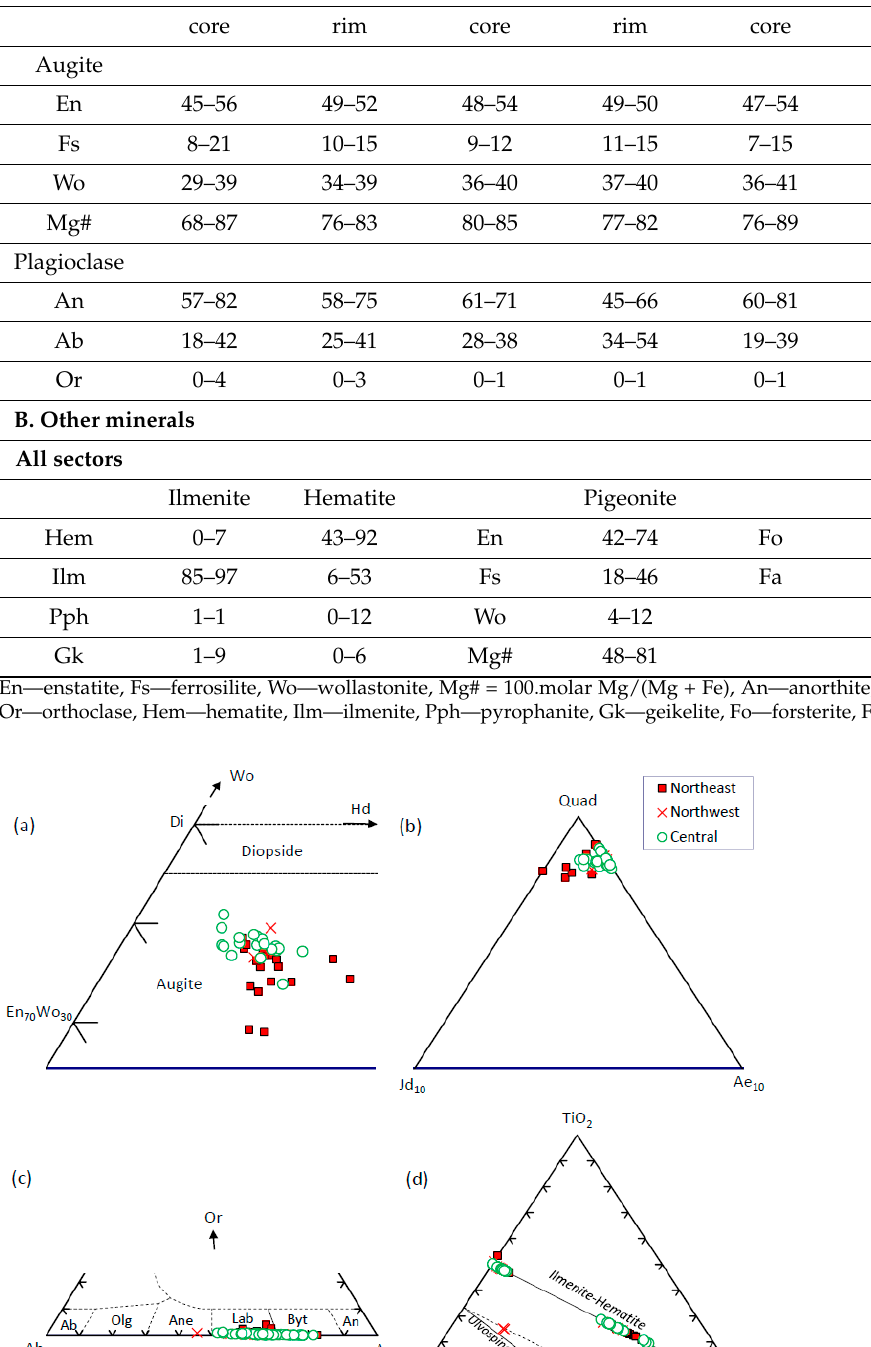
Table 2. Composition range of minerals in the Rajmahal basalts.